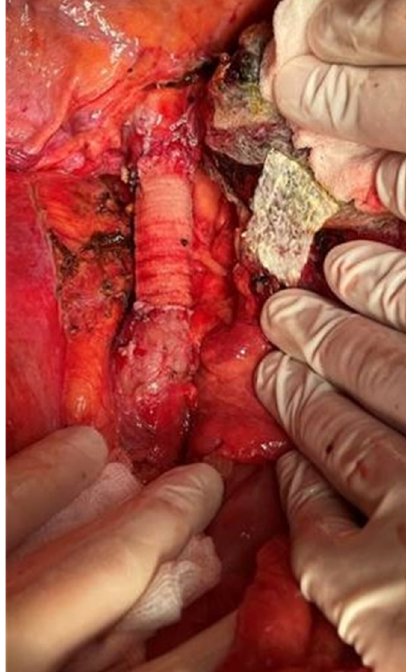
Figure 3. The final aspect after resection: the continuity of the cava vein was re-established by placing a Gore-Tex graft; the left suprahepatic vein and its implantation was successfully preserved.